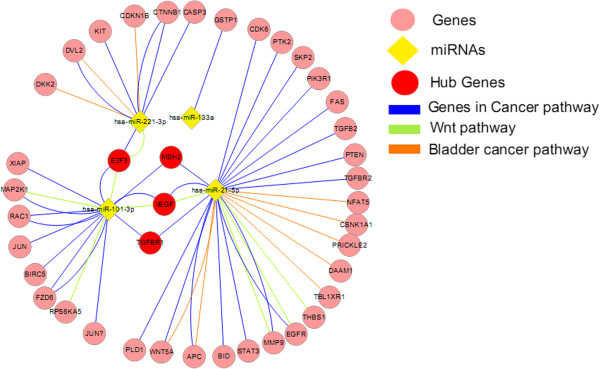
MicroRNA (miRNA) to mRNA network visualized by Cytoscape. Pink dot represents target genes and red dot represents hub genes; yellow rectangle is miRNA; blue edge indicates target gene located in the pathway of human cancer; green edge means that target gene is located in the Wnt signaling pathway and orange edge that target gene is located in the bladder cancer pathway.